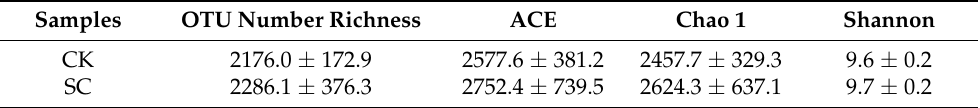
Table 2. Alpha diversity of different sites ( n =